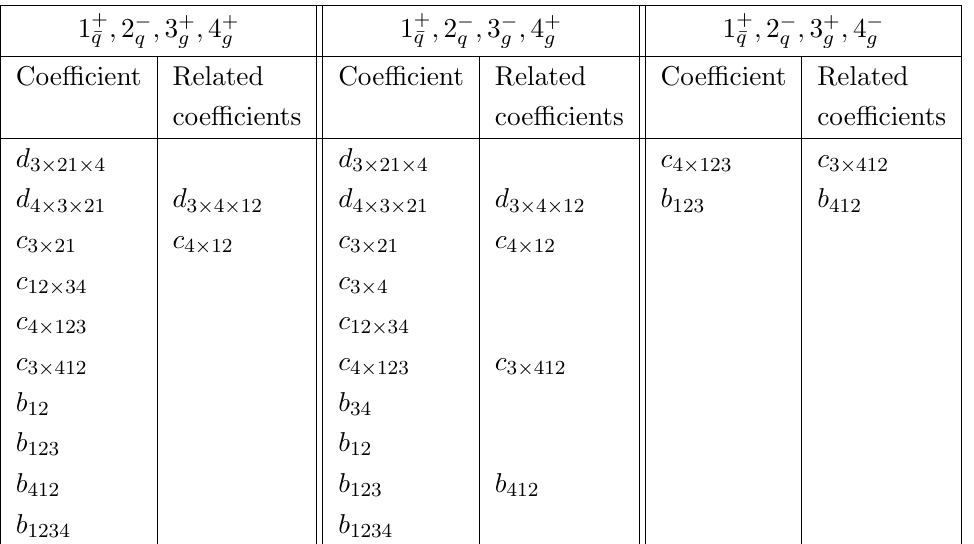
(1 + ; 2 (cid:0) ; 3 (cid:0) ; 4 + ) and (cid:22) q q g g 4